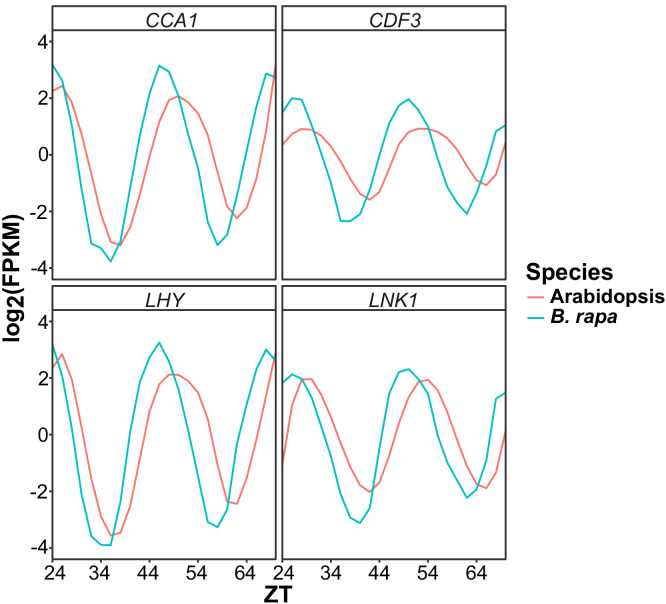
Phase variation between Arabidopsis and B. rapa clock genes.Gene expression expressed as log2 transformed FPKM values for four circadian clock genes (CCA1, CDF3, LHY, and LNK1) from the Arabidopsis microarray data and B. rapa RNAseq data used in this study. Due to the variation in the circadian period in Col-0 and B. rapa R500 there are visible phase differences as seen by the shift in peak timing of expression.